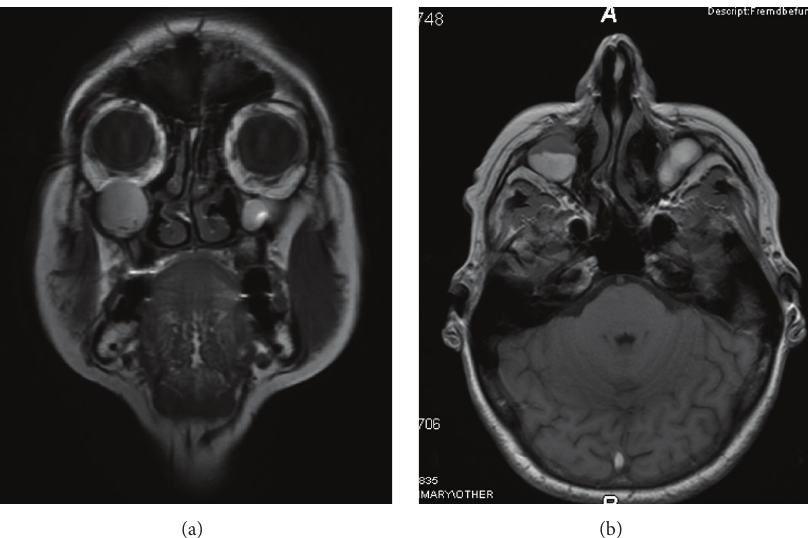
Figure 4: MRT (T2): coronal (a) and sagittal (b) view. Bilateral cystic lesions of the maxillary sinus with elevation of the orbital floor on the right